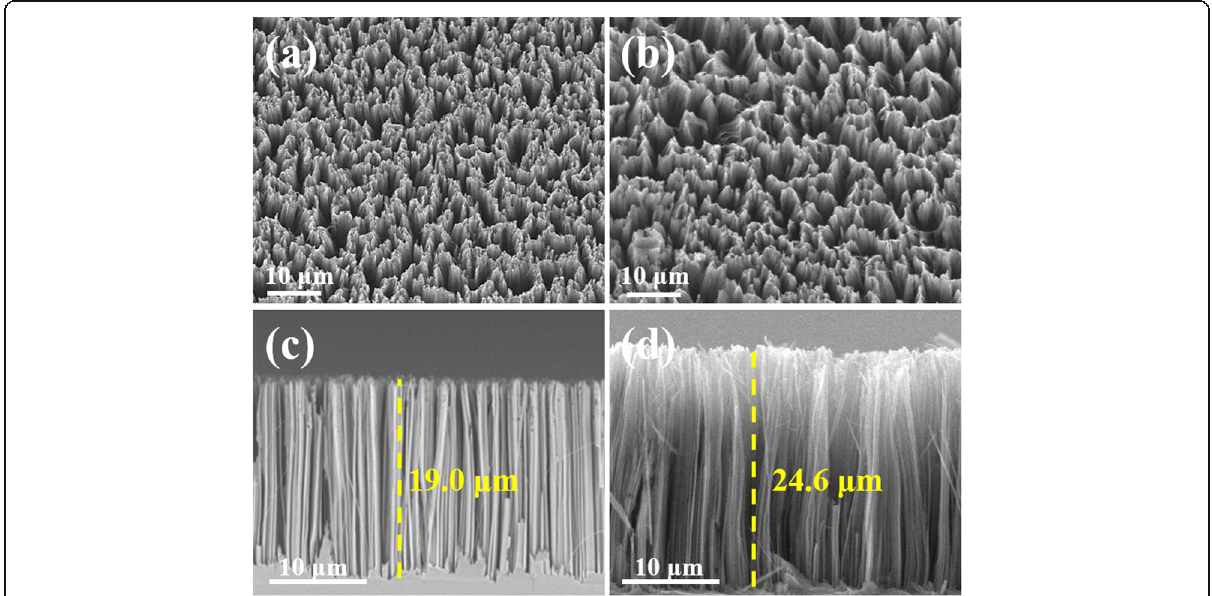
Fig. 1 SEM images of the catalysts: a and c the top view and sectional view of p-type Si NWs; b and d the top view and sectional view of n-type Si